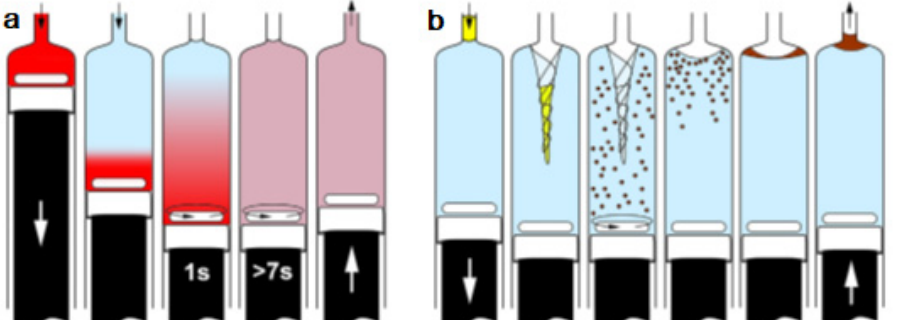
Figure 5. Schemes of both operation procedures tested in this work. ( a ) Mixing and homogenization of rhodamine B solution and water, and ( b ) MSA-DLLME of LMG-Al complex with n-hexanol [27]. ↑ ↓ ↑ ↓ dispense.